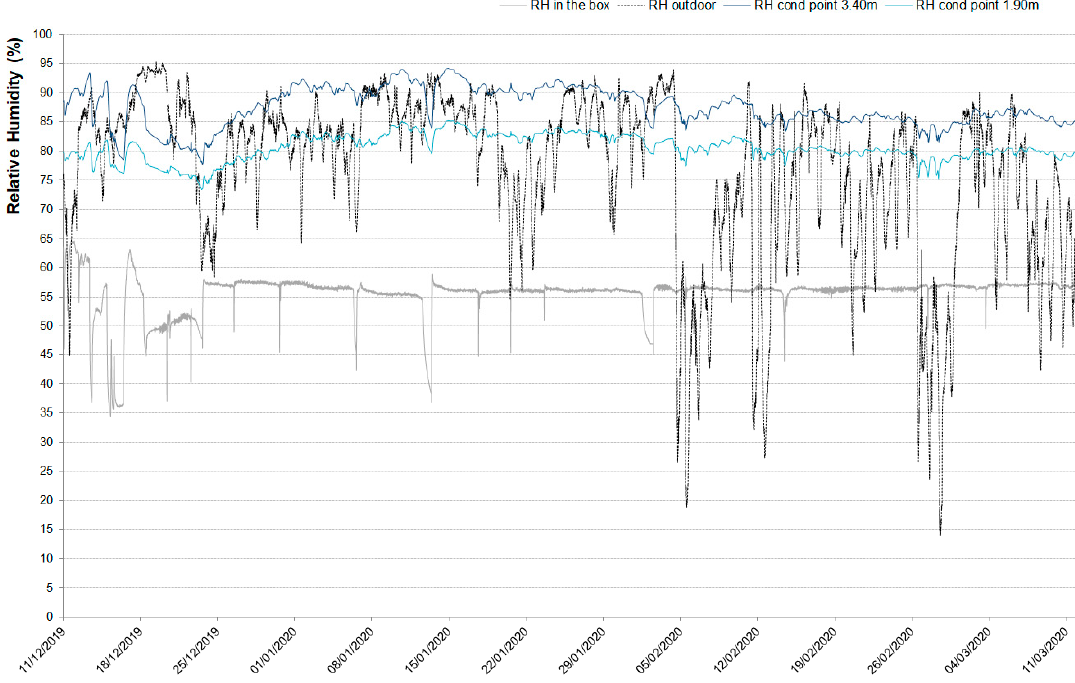
Figure 12. Graphical representation of the relative humidity (RH) values between 11 December 2019 and 11 March 2020.